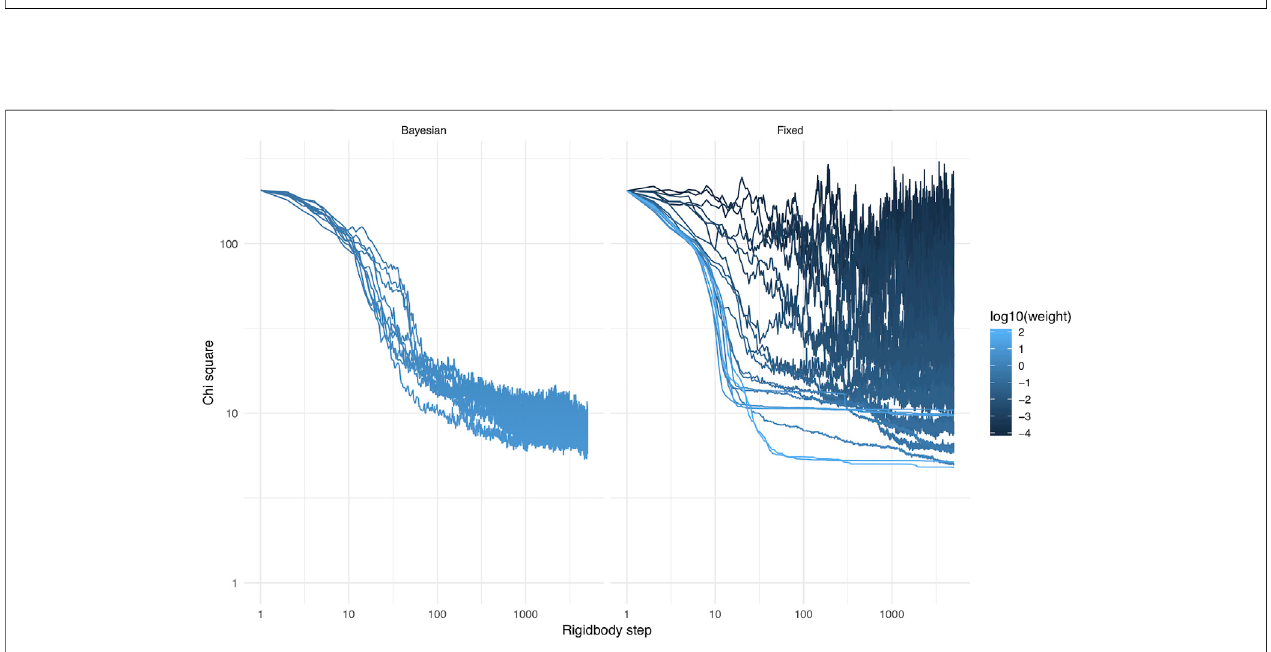
FIGURE 5 | The adjustment of the Bayesian SAXS score. (A) χ 2 and (B) SAXS restraint weight of a composite simulation, starting from rigid body steps (blue), followed by linker modelling (yellow, pointed to by arrows), and ending with Monte Carlo fl exible re fi nement (red).